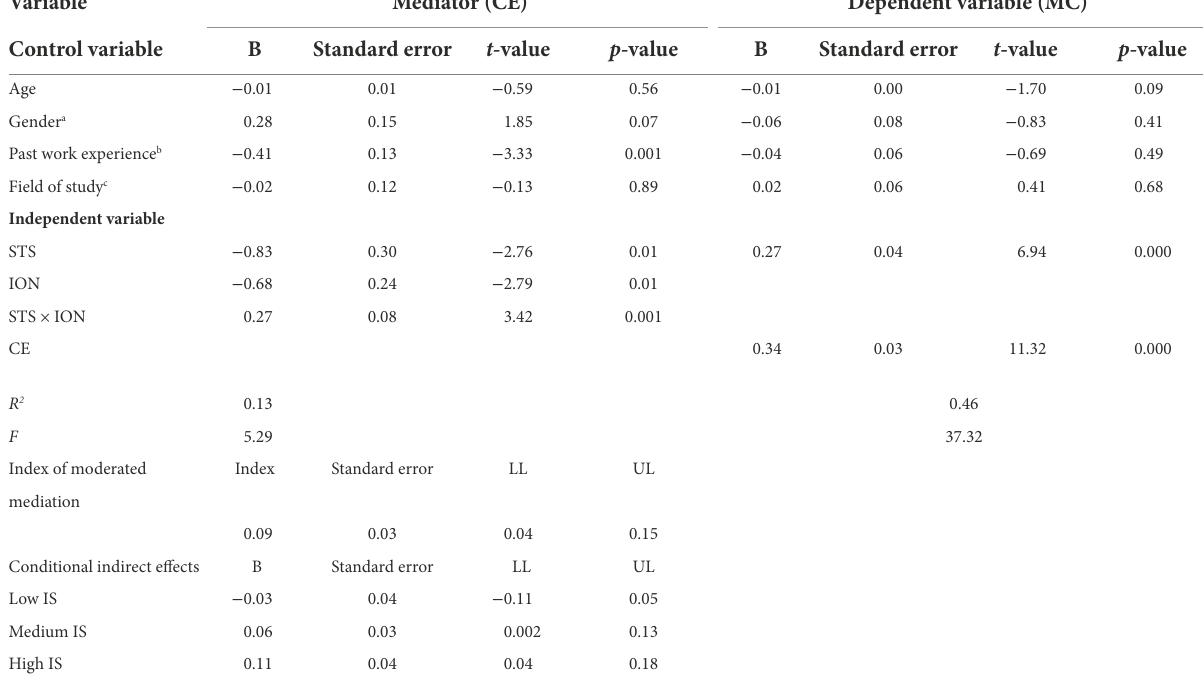
TABLE 4 Summary of the moderated mediation analysis (Research Question 1).